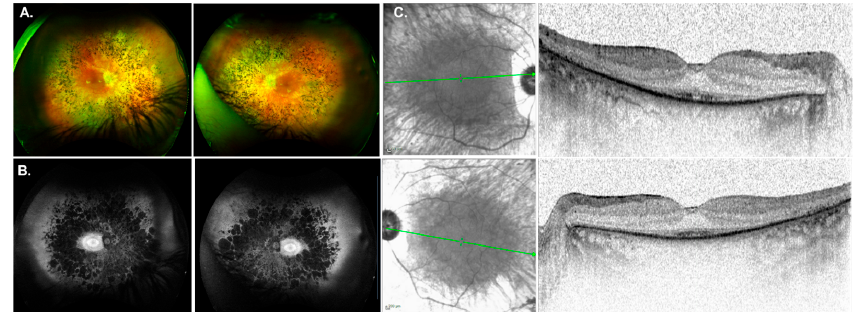
Figure 3. Phenotype associated with CEP83 mutations. ( A ) Fundus images for GP037 were